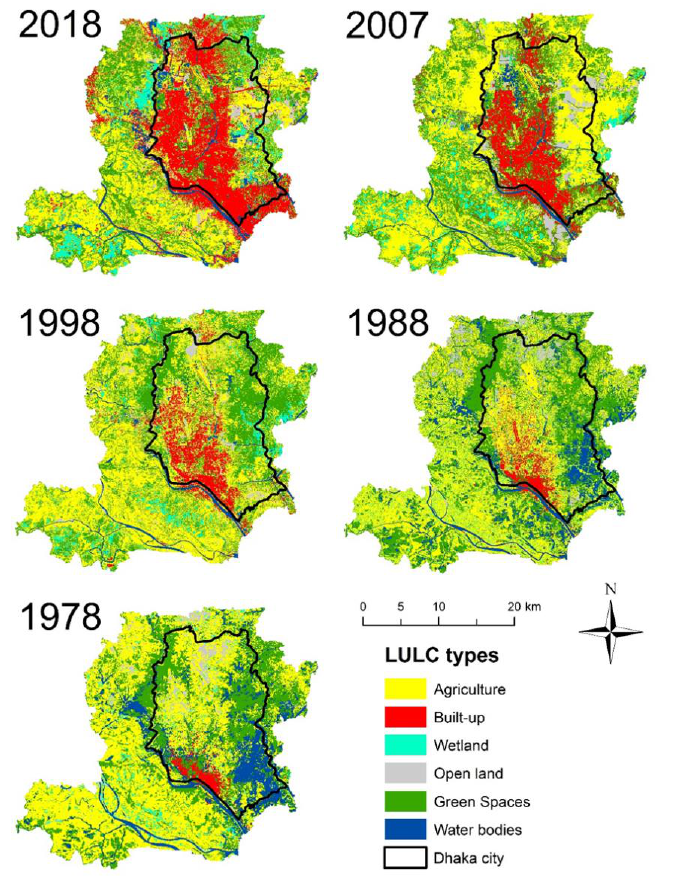
Figure 6. Decadal land use/land cover maps (classified).